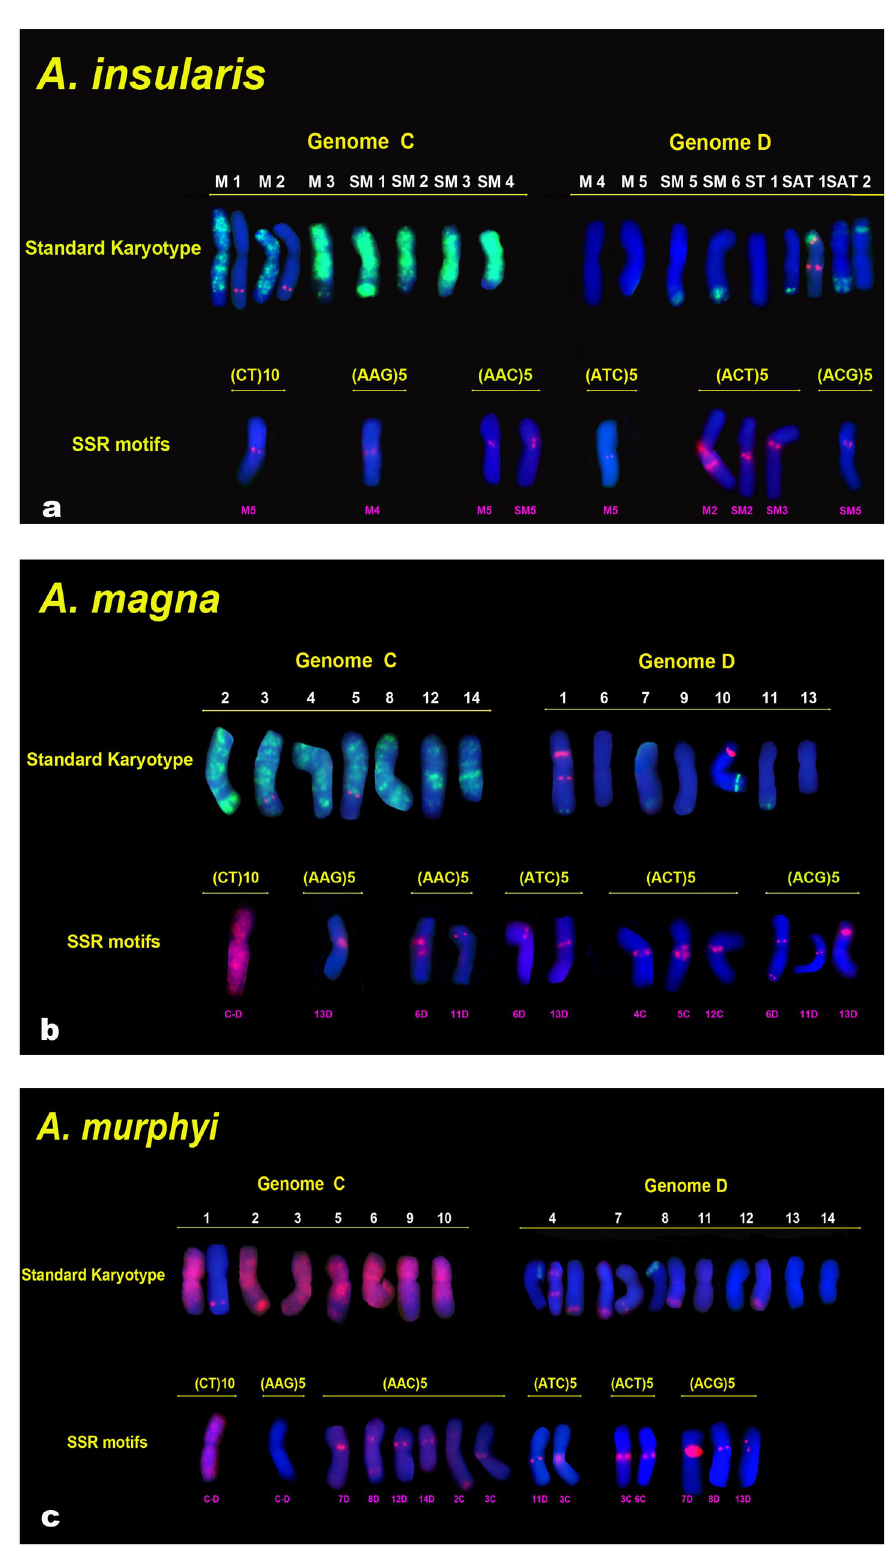
Fig 3. Karyotypes of CCDD tetraploid species showing a single chromosome of each homologous pair from the metaphases of cells in Fig 3. Standard karyotypes are based on the FISH distribution patterns of Am1, 45S and